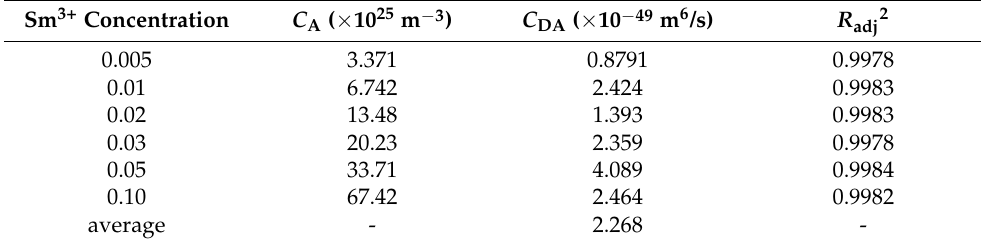
Table 4. Relevant parameters in I-H model analysis in Ce 3+ and Sm 3+ co-doped samples. Sm 3+